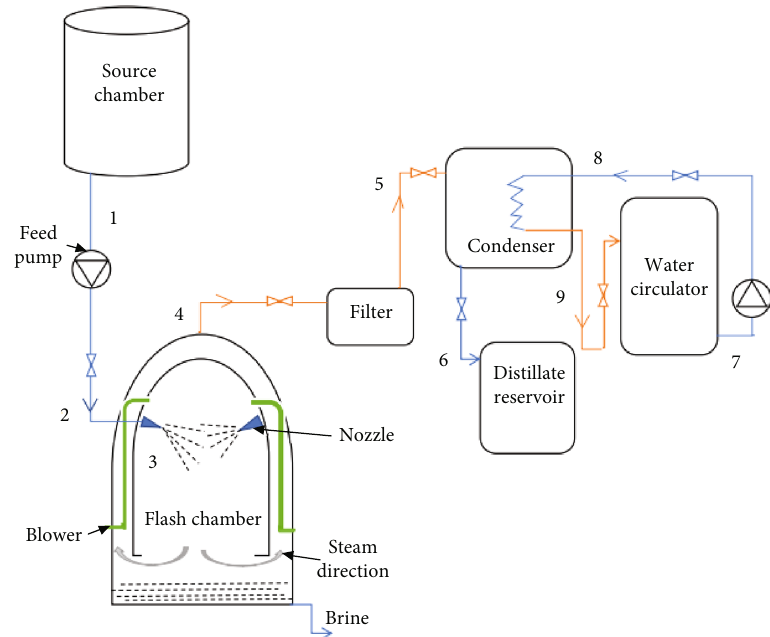
Figure 1: The current layout of spray fl ash evaporation system.